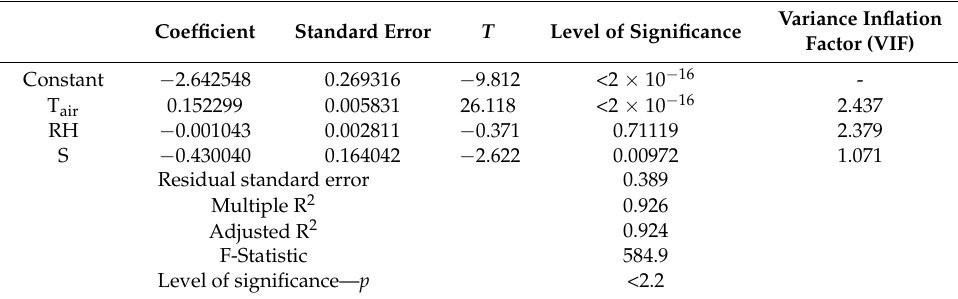
Table 6. Statistical analysis of the constant, three independent variables and variance for the regression performed with the complete series (January and July